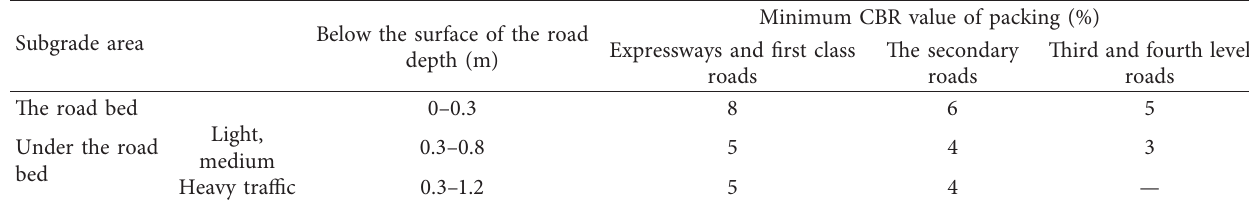
Table 5: Minimum bearing ratio requirement of roadbed filling.